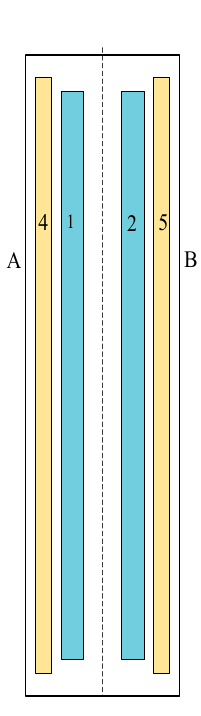
Figure 12. Air window with windings.